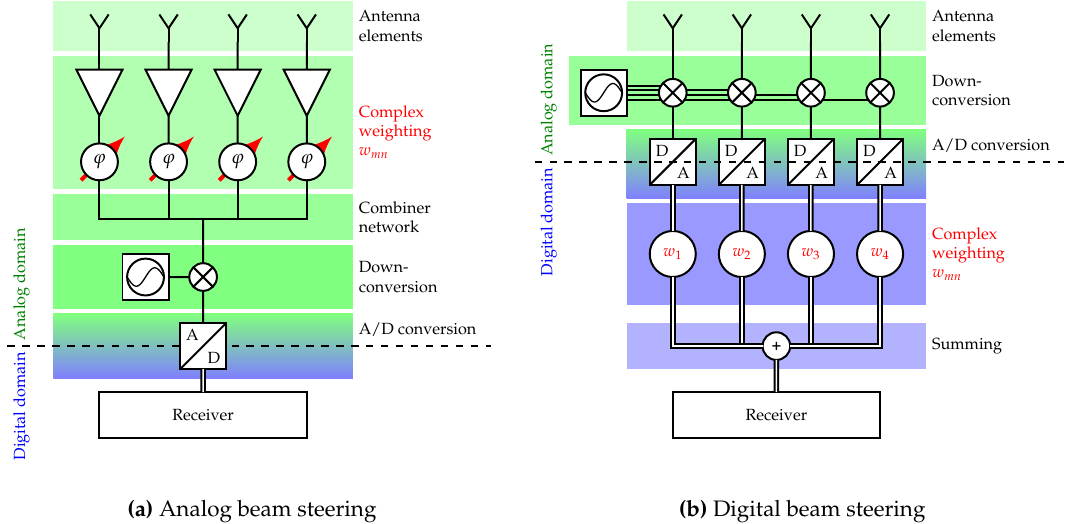
Figure 11. Possible implementation of the weighting functions w mn for array antennas. The block diagrams are simplified in such a way that all components and stages not essential for signal weighting are neglected.